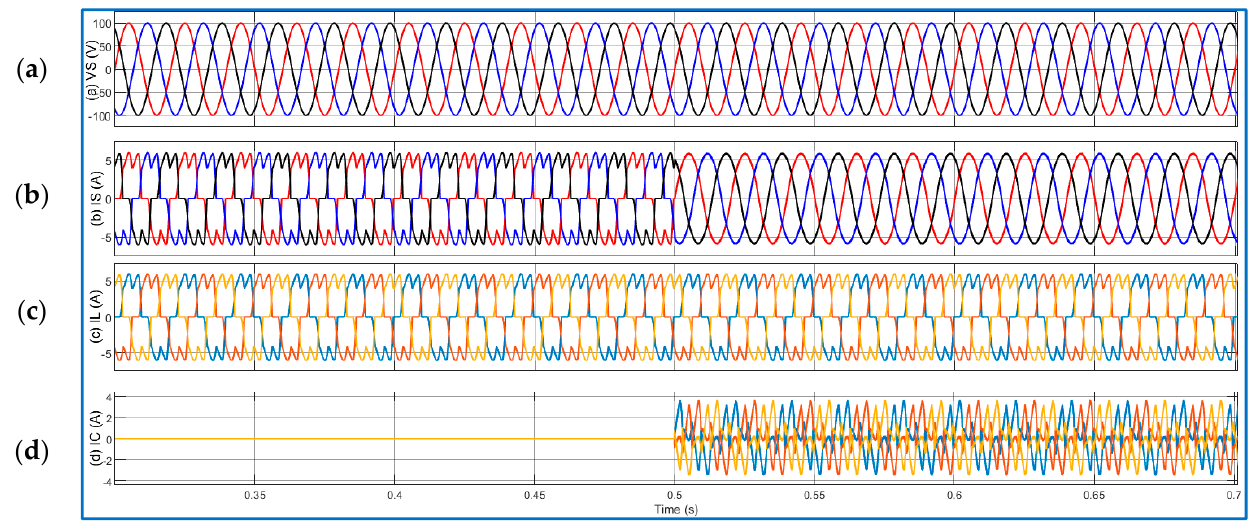
Figure 11. Single phase: ( a ) VS: supply voltage; ( b ) IS: supply current; ( c ) IC: compensator current; ( d ) VC: compensator voltage.